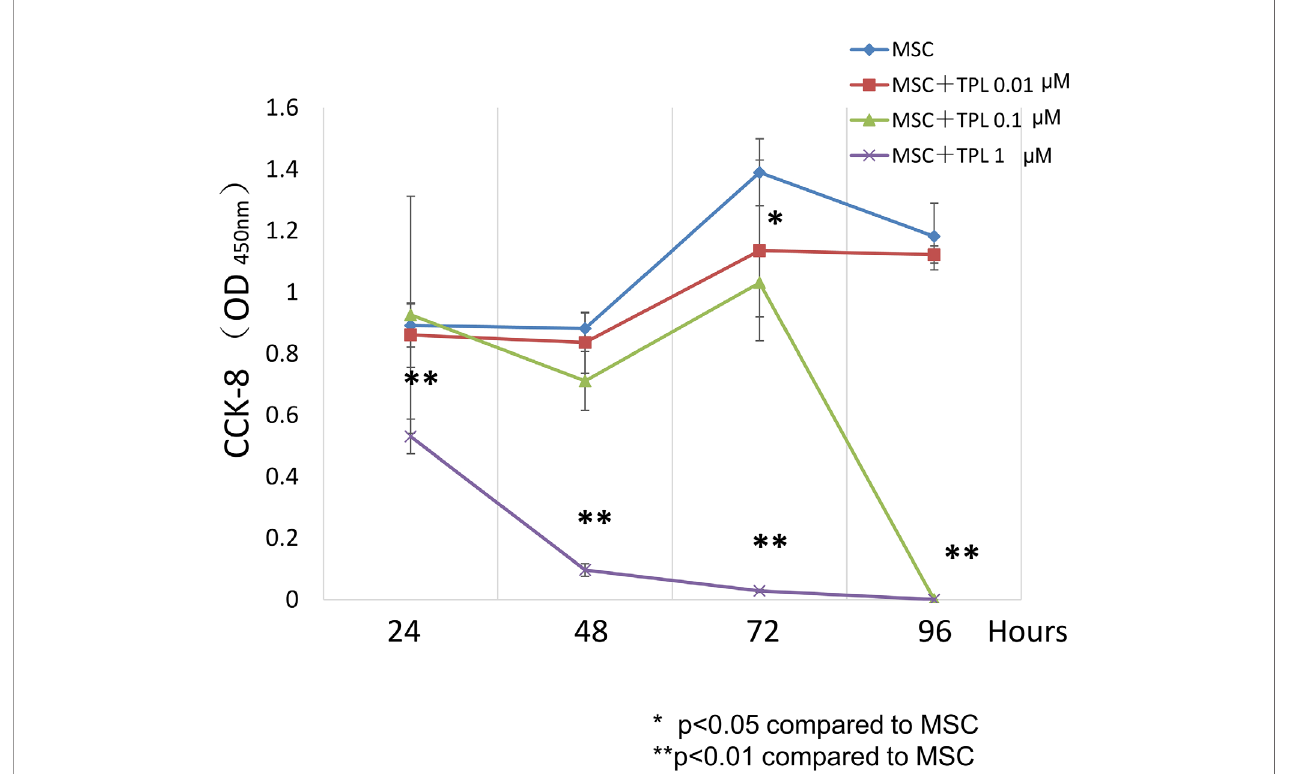
FIGURE 1 | Effect of TPL on the UC-MSC proliferation. CCK8 cell viability assay performed 24, 48, 72, and 96 h after treatment with 1, 0.1, and 0.01 m M TPL; non-primed UC-MSCs were used as the control group. Quantitative data have been presented as the mean value of three different samples ± SD with **p < 0.01, compared to the UC-MSC control group. MSC, UC-MSCs; TPL,